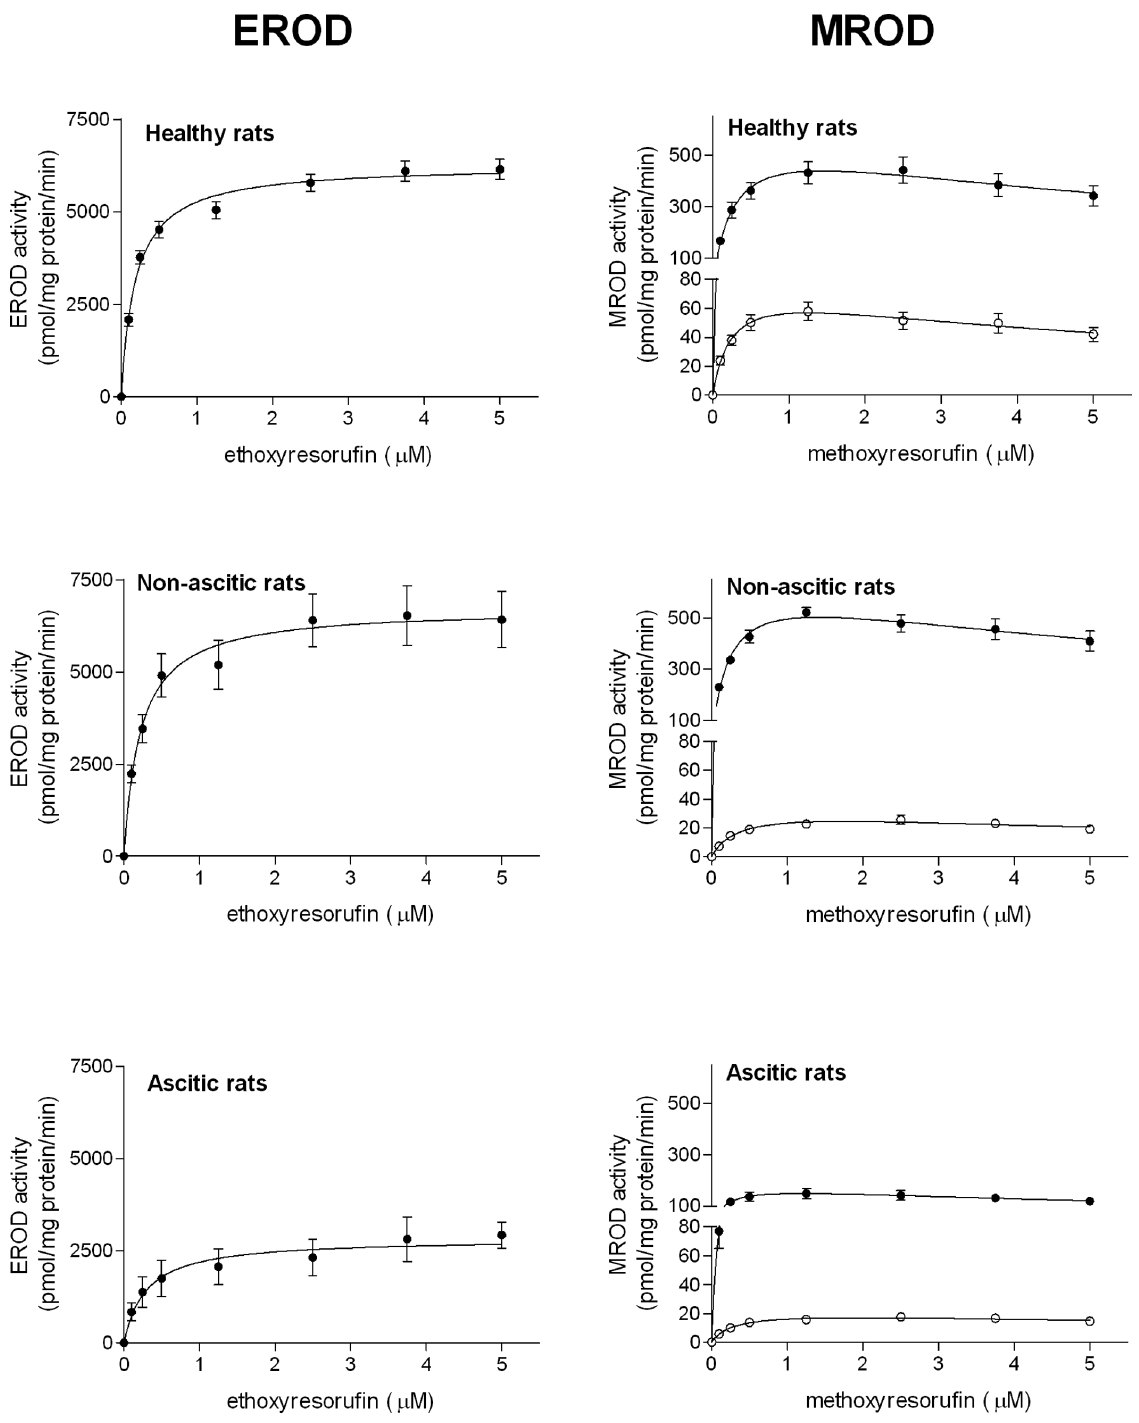
N ) rats. Results are